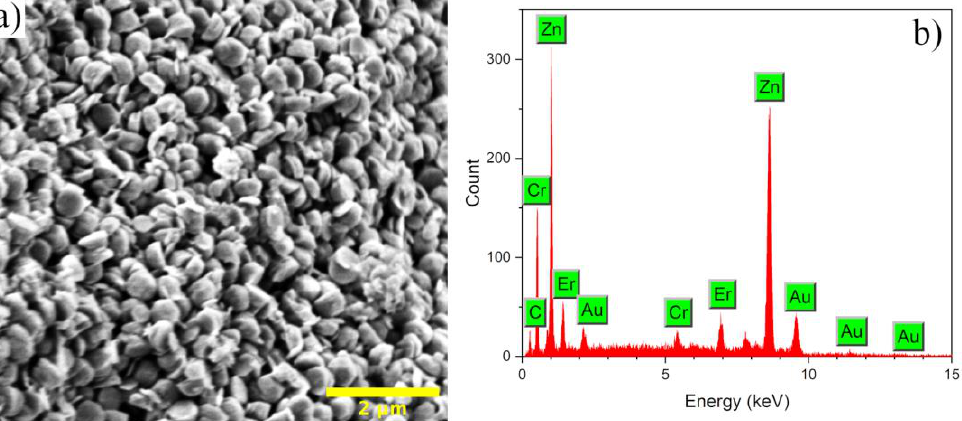
Figure 3. ( a ) SEM image and ( b ) EDS spectrum of the Zn 0.94 Er 0.02 Cr 0.04 O compound synthetized by co-precipitation.